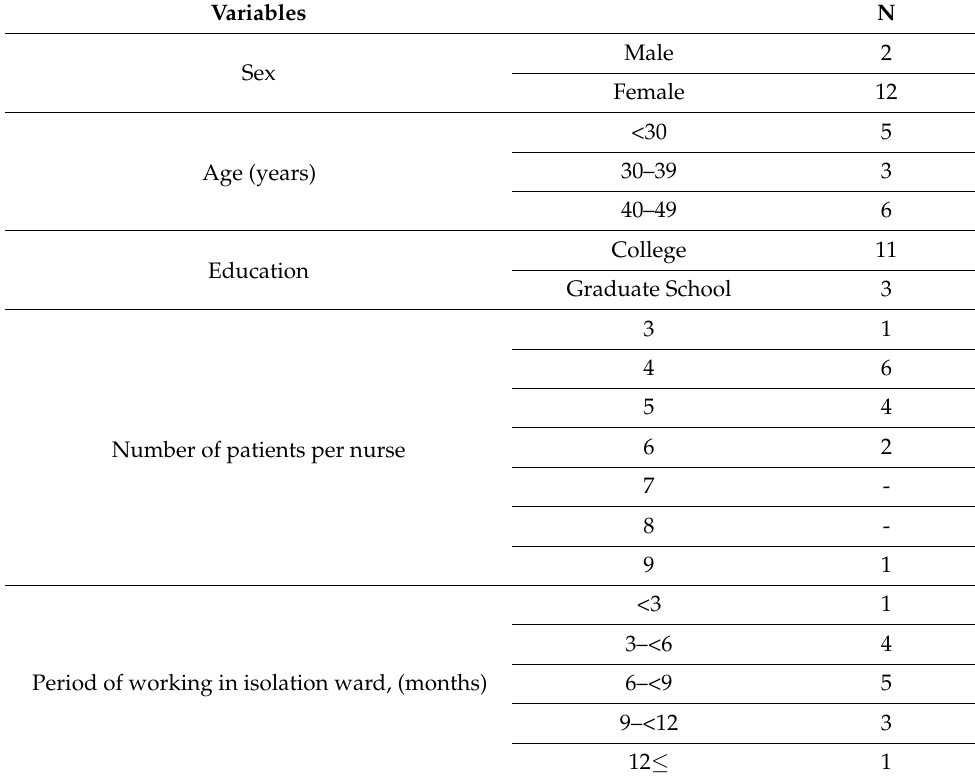
Table 1. General Characteristics of Participants ( N =